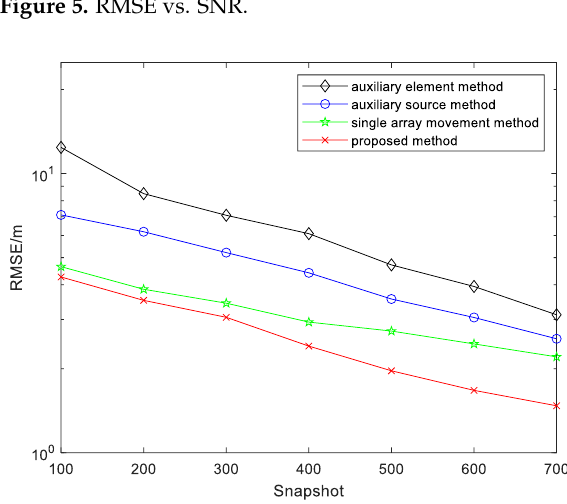
Figure 6. RMSE vs. snapshot.